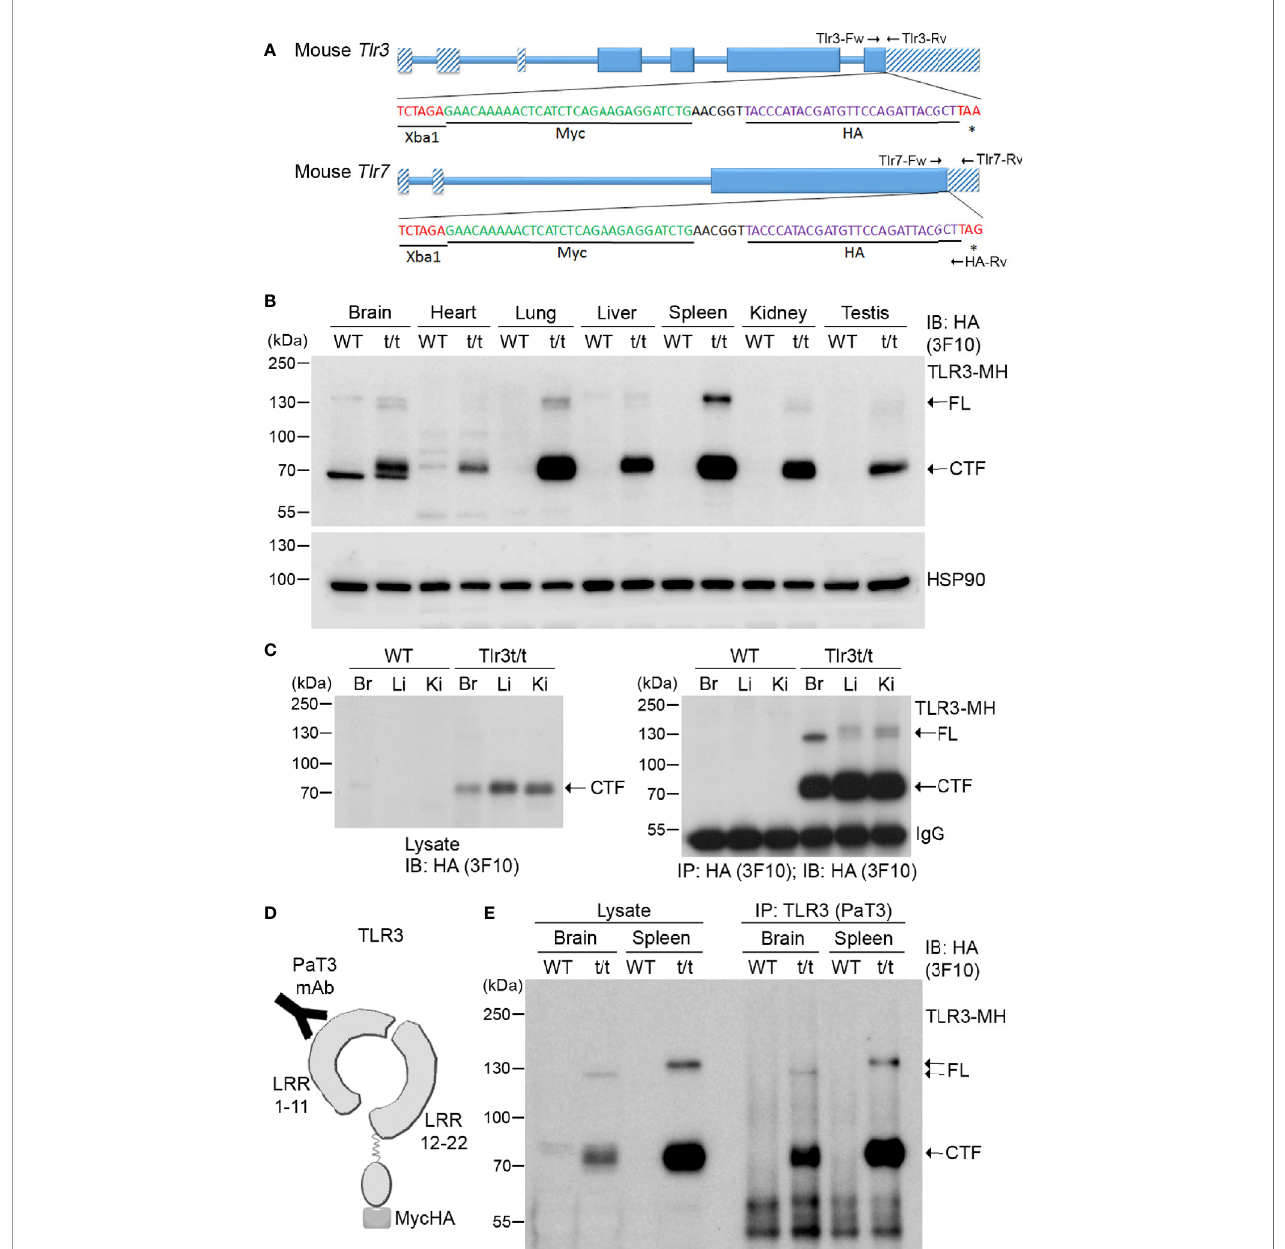
FIGURE 3 | Dual tagging of Myc and HA cassettes at the C-terminal ends of the Tlr genes reveals expression and processing of TLR. (A) Schematic of the mouse Tlr3 and Tlr7 genes in which a Myc-HA epitope tag has been inserted before the stop codon. Two primer sets, i.e. Tlr3-Fw and Tlr3-Rv for Tlr3 and Tlr7-Fw, Tlr7-Rv and HA-Rv for Tlr7 , were used for genotyping the tagged Tlr3 and Tlr7 mice. The results of genotyping are available in Supplementary Figure 2 . *, stop codon. (B) Detection of TLR3-MH protein in multiple tissues of Tlr3 t/t mice using immunoblotting (IB) with anti-HA antibody (3F10). HSP90 was used as a loading control. (C) Anti-HA antibody (3F10) was used in immunoprecipitation (IP) of TLR3-MH from brain (Br), liver (Li) and kidney (Ki) of WT and Tlr3 t/t mice. The IP complex was then analyzed by IB with the same anti-HA antibody. (D) Schematic of TLR3 protein with the C-terminal dual Myc-HA tag. The PaT3 monoclonal antibody recognizes the N-terminal region of TLR3. (E) The N-terminal (NTF) and C-terminal (CTF) fragments of TLR3 remain associated with each other after proteolytic cleavage. TLR3 was precipitated using the PaT3 antibody from brain and spleen lysates of WT and Tlr3 t/t mice. The IP complex was then subjected to IB analysis using anti-HA antibody (3F10). FL, full-length TLR3-MH; CTF, C-terminal fragment of TLR3-MH; IgG, immunoglobulin heavy